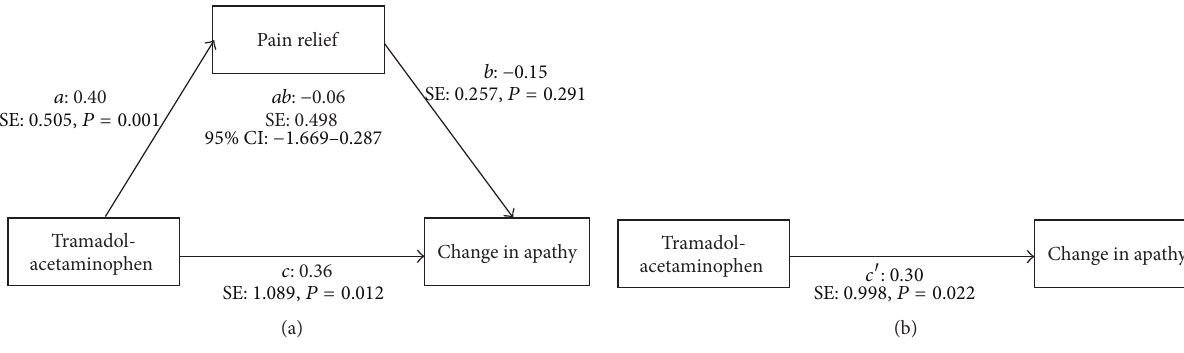
Figure 1: Standardized coefficients mediation models showing the indirect (a) and direct (b) effects of tramadol-acetaminophen on change in apathy. 𝑎 , 𝑏 , 𝑐 , and 𝑐 󸀠 indicate standardized coefficients. SE: standard error; 95% CI: 95% confidence interval.